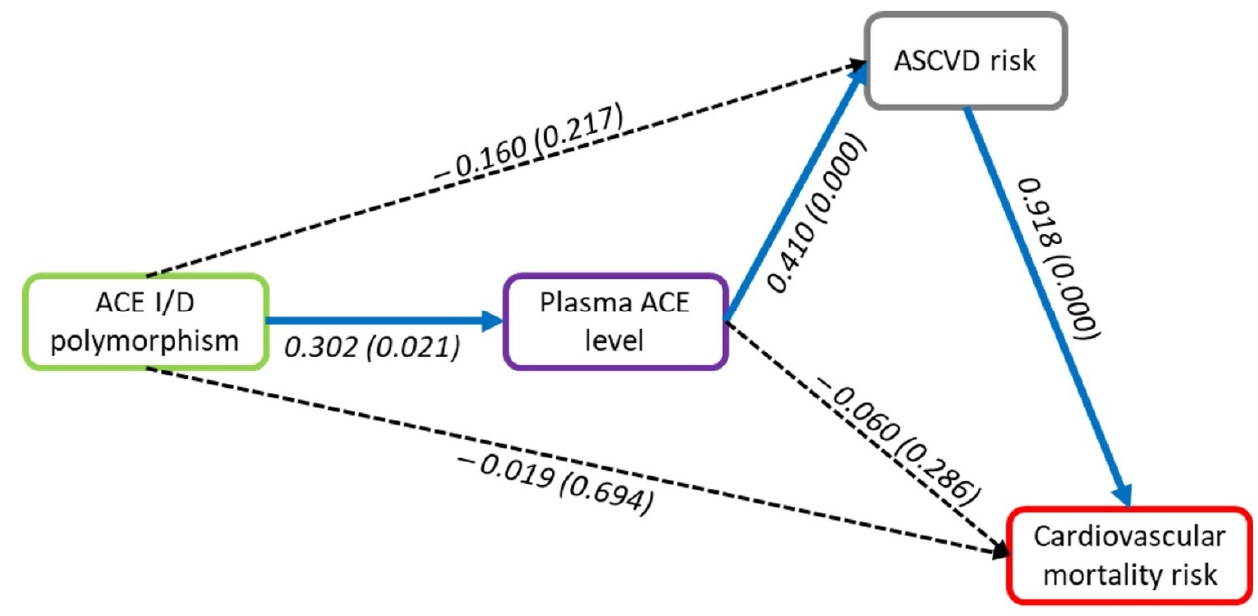
Figure 5. Analysis of ACE levels, ASCVD risk, and cardiovascular mortality risk between different ACE I/D genotypes (Kruskal–Wallis with Mann–Whitney post-hoc test). ( a ). Patients with DD genotype displayed higher plasma ACE levels compared to II or ID genotypes. ( b ). No difference was observed in ASCVD risk between the three genotypes. ( c ). No difference was observed in cardiovascular mortality risk between the three genotypes.* = significant at p < 0.05